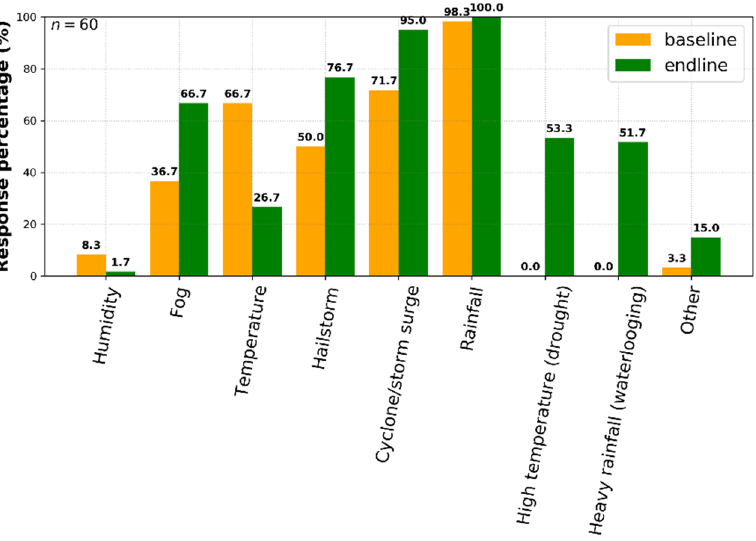
Figure 4. Baseline versus endline weather information needs of smallholder farmers in the Lower Bengal Delta around Khulna, Bangladesh.